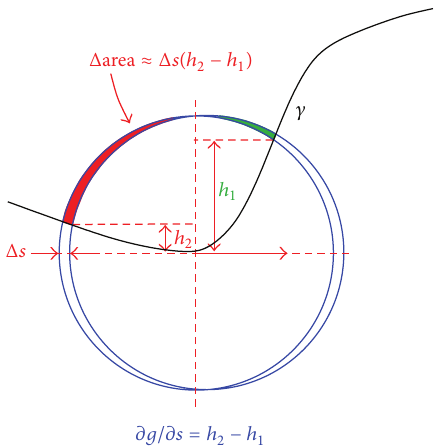
Figure 9: Deriving 𝜕𝑔/𝜕𝑠 as the difference in heights of the entry and exit points.